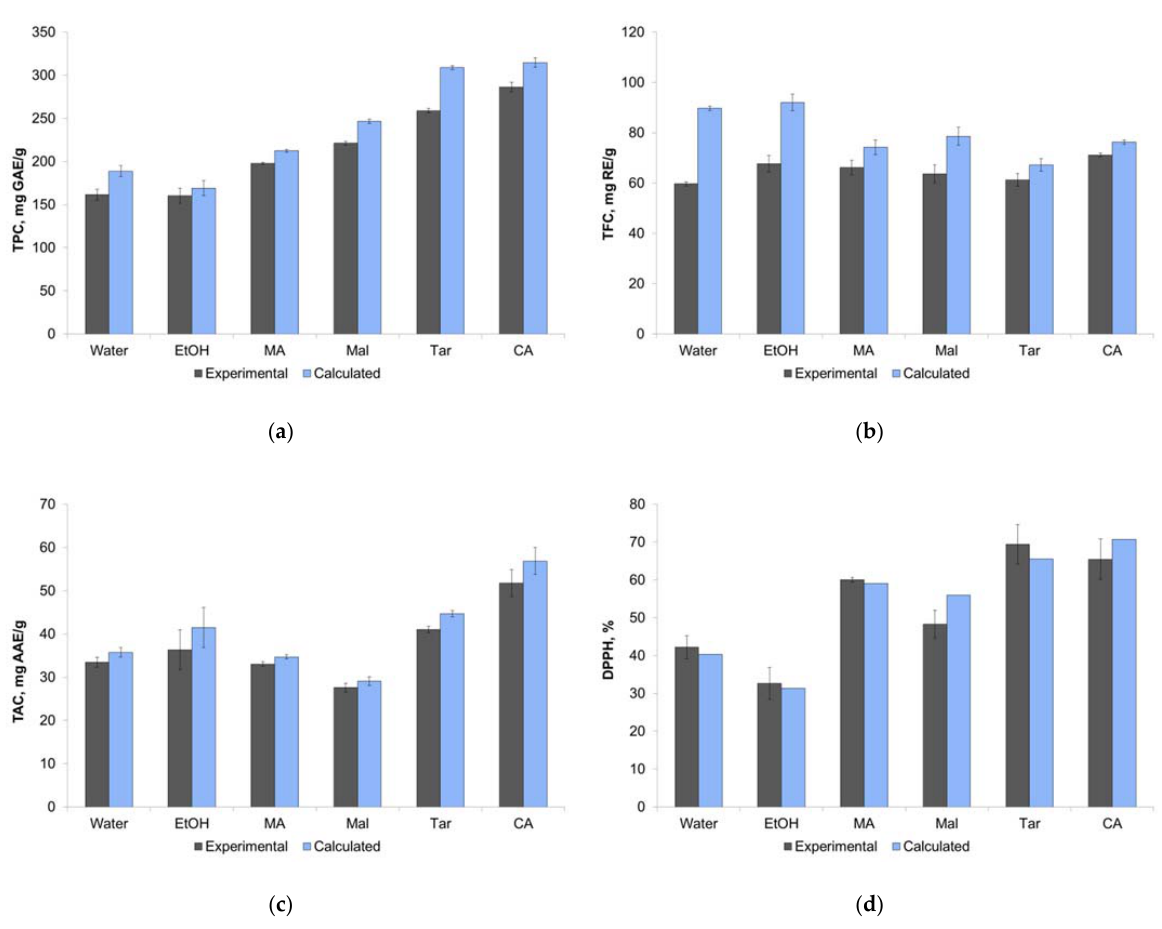
Figure 3. Comparison of extraction efficiency from experimental and calculated data for different solvents by parameters TPC ( a ), TFC ( b ), TAC ( c ), and DPPH ( d ). Data are presented with ± SD of three repetitions. Table 3. Results of Tukey’s HSD test of estimation a statistically significant difference at p ≤ 0.05 between solvents for TPC, TFC, TAC, and DPPH.